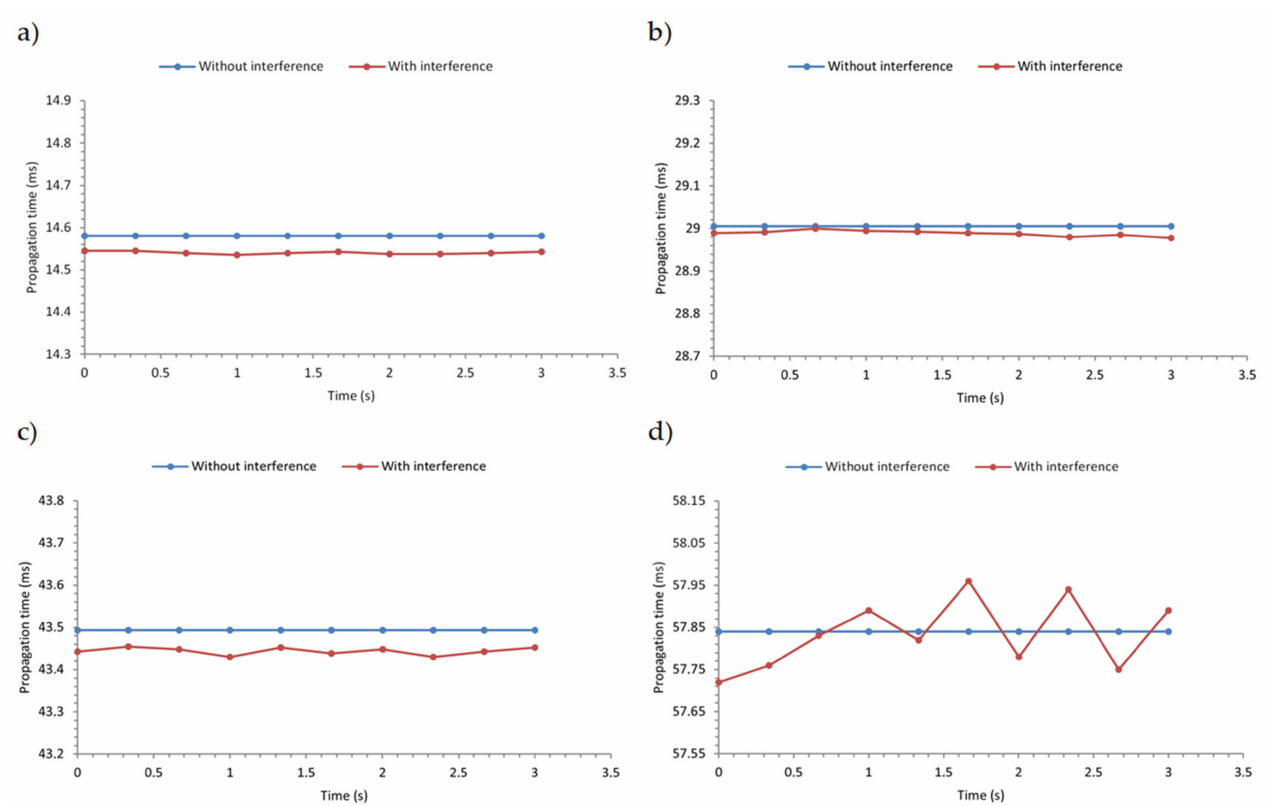
Figure 12. The effect of medium interference on the wave propagation time between AR30 transducers at different distances between the transmitter and receiver: ( a ) 5 m; ( b ) 10 m; ( c ) 15 m; ( d ) 20 m.